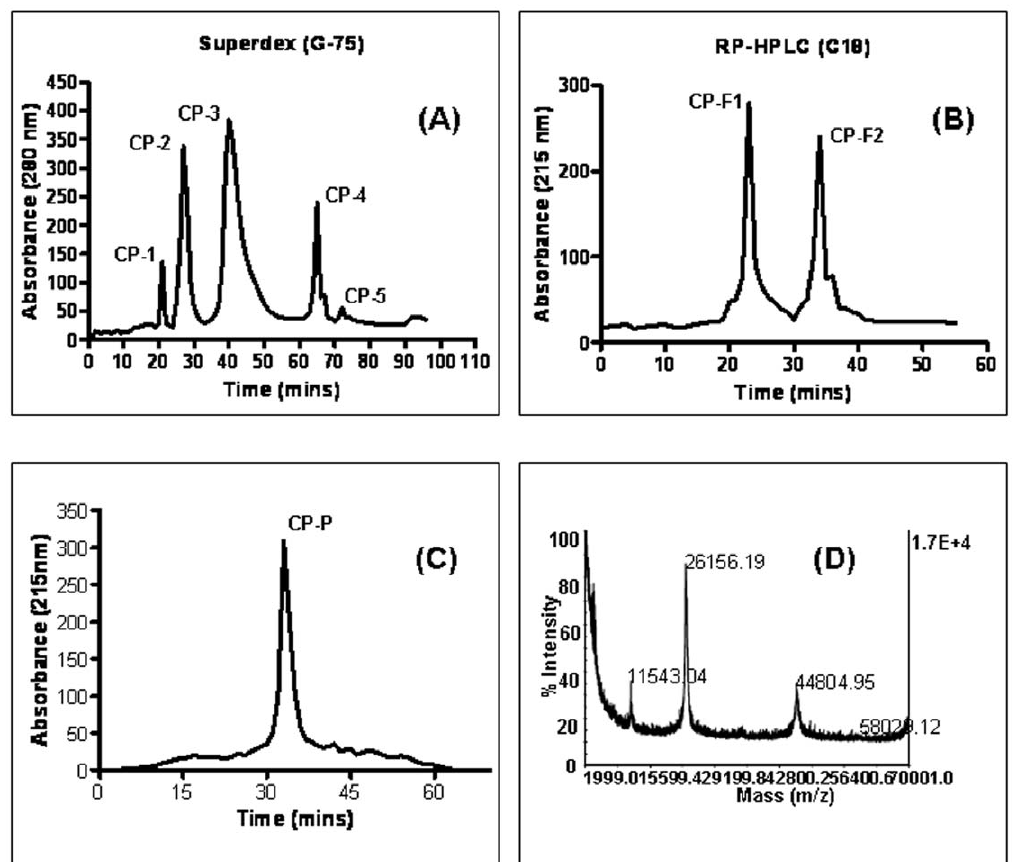
Figure 1. Purification and characterization of anticancer protein CP-P. (A) The clear supernatant of Calotropis procera root-bark was separated by gel-filtration (Superdex G-75) chromatography into five major peaks CP-1–CP-5, (B) the most active peak (CP-3) was further separated by reverse-phase high performance liquid chromatography (RP-HPLC) by using a C18 column which produced two peaks namely CP-F1 and CP-F2, (C) the active fraction (CP-F1) was resolved by a C8 column and gave a single peak named Calotropis procera protein ‘‘CP-P’’, (D) CP-P mass was analyzed by a perspective biosystem matrix-assisted laser desorption ionization-time of flight (MALDI-TOF/MS).